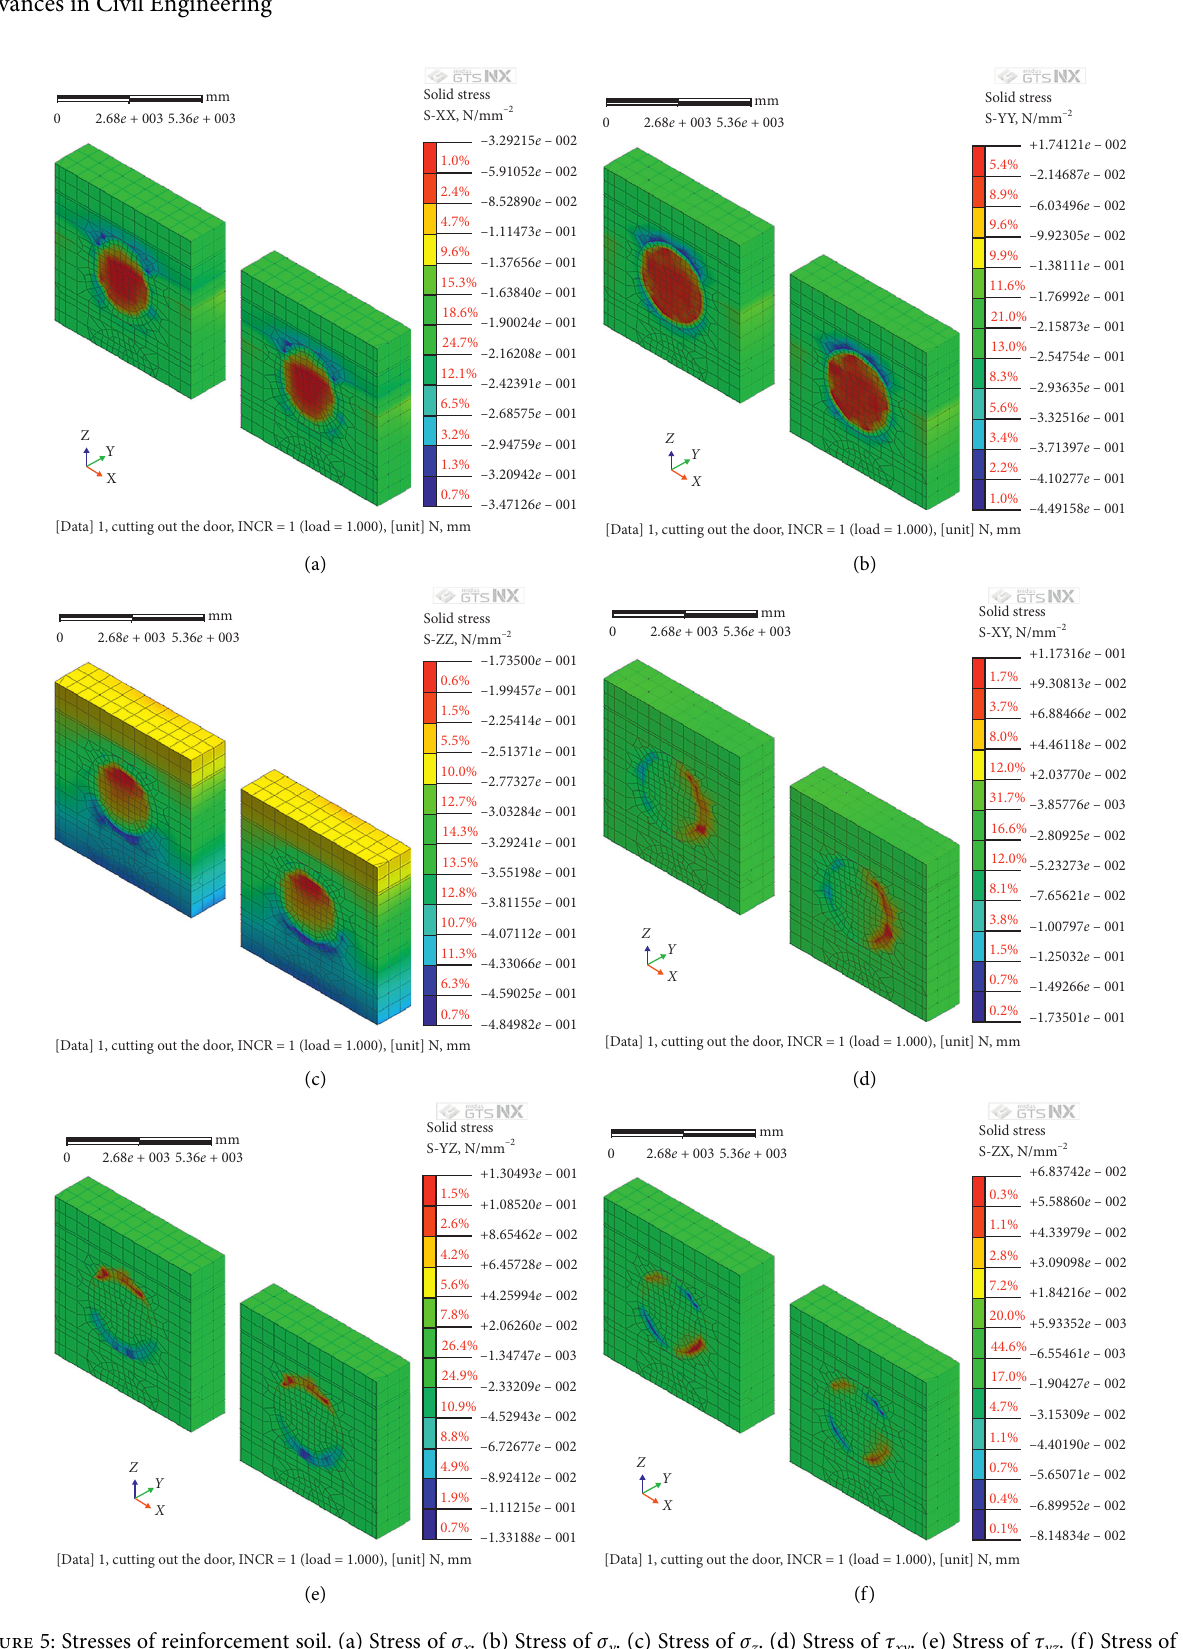
Figure 5: Stresses of reinforcement soil. (a) Stress of σ x . (b) Stress of σ y . (c) Stress of σ z . (d) Stress of τ xy . (e) Stress of τ yz . (f) Stress of τ xz